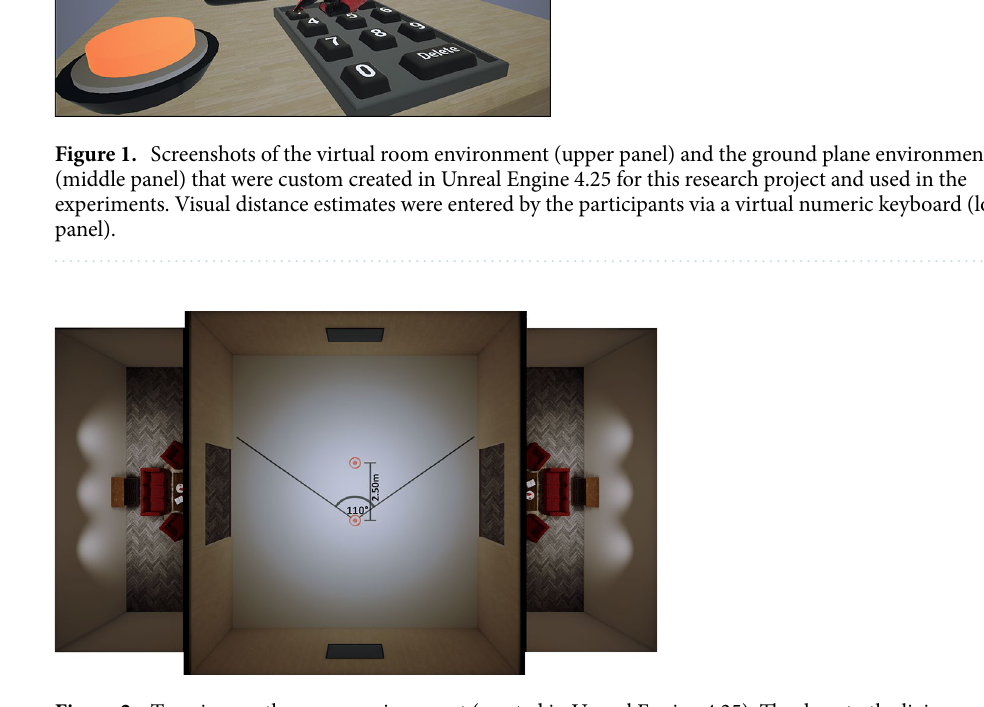
Figure 2. Top view on the room environment (created in Unreal Engine 4.25). The door to the living rooms on both sides had a size that ensured that they were outside of the field of view, when participants were looking forwards, hence preventing them from causing additional motion cues such as parallax (created in